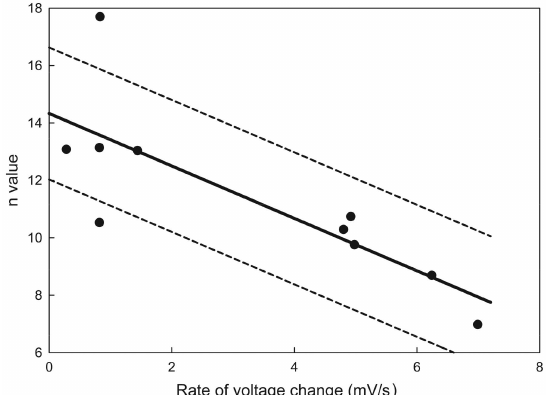
Figure 6. Estimate of the e ff ective number of gating charges, n. The values plotted were the results of Boltzmann distribution fits to the gating of channel 2 as the voltage was varied at di ff erent rates. The data originated from ten separate experiments. The solid line is the least squares fit, and the dotted lines show the 95% confidence limits. Extrapolation to zero rate of voltage change yields a value for n (equilibrium value) of 14 ±